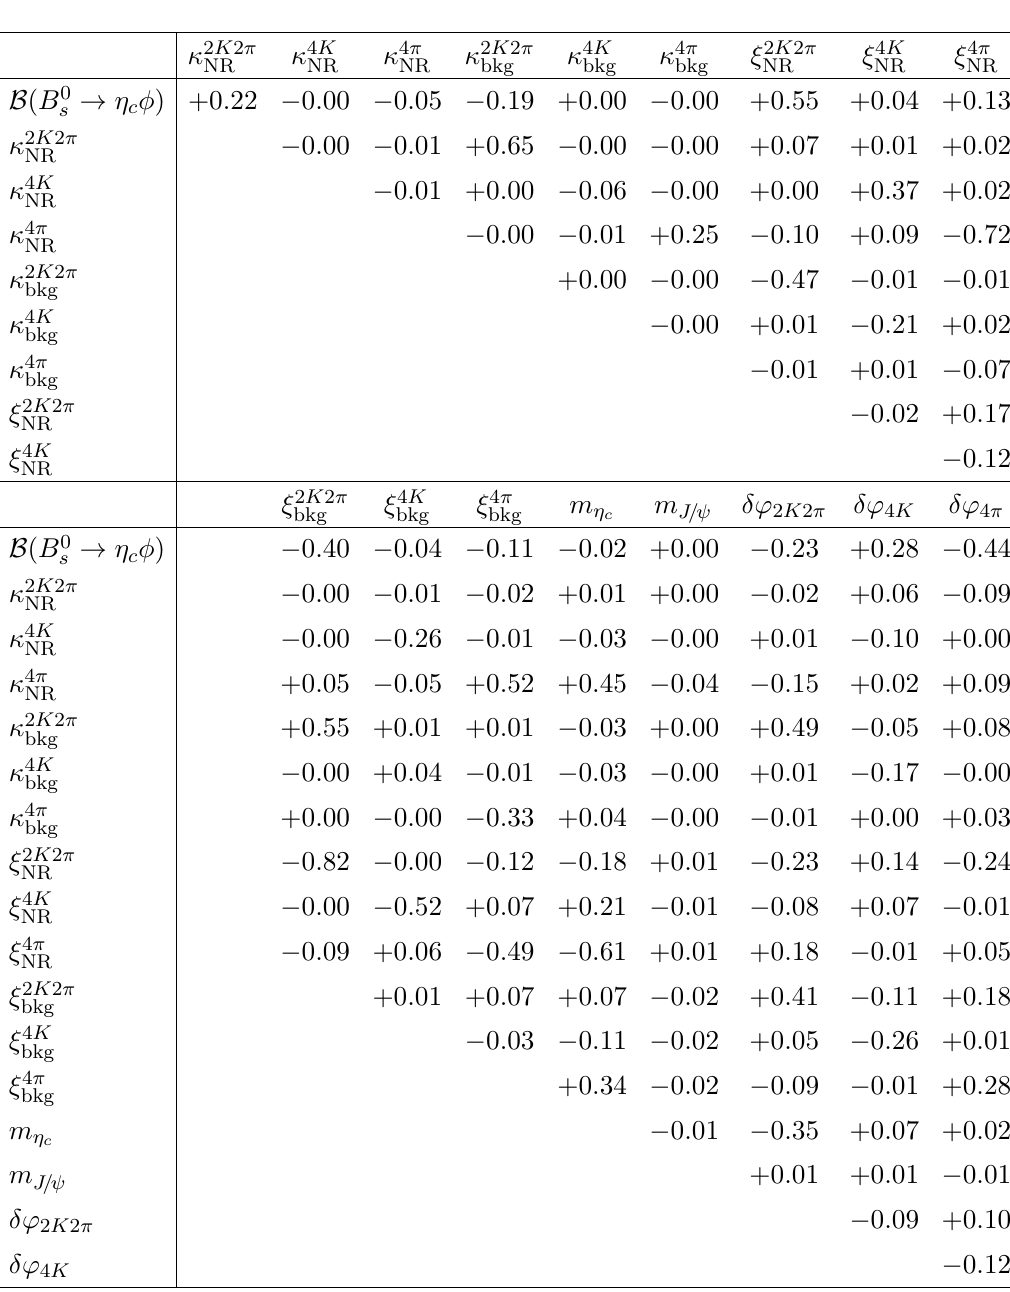
Table 7 . Statistical correlation matrix for the parameters from the simultaneous (cid:12)t to the p (cid:22) p and 4 h invariant-mass spectra for B 0